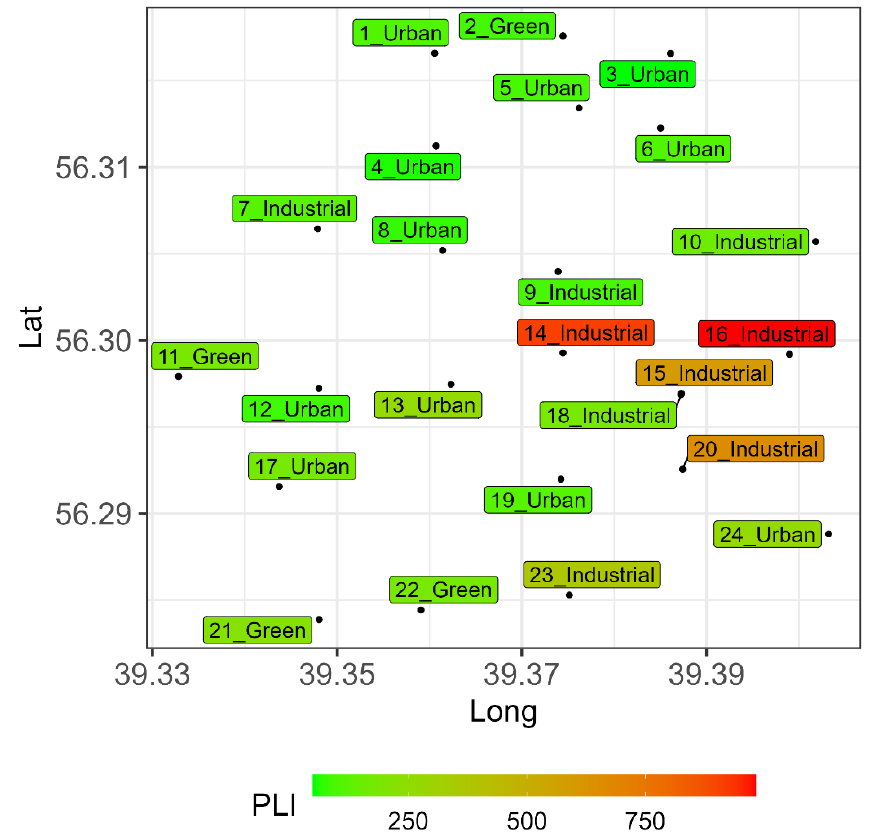
Figure 10. The distribution of PLI and the corresponding areas obtained by LULC.